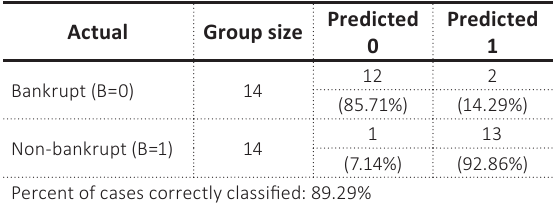
Table 16. Classification results ( t